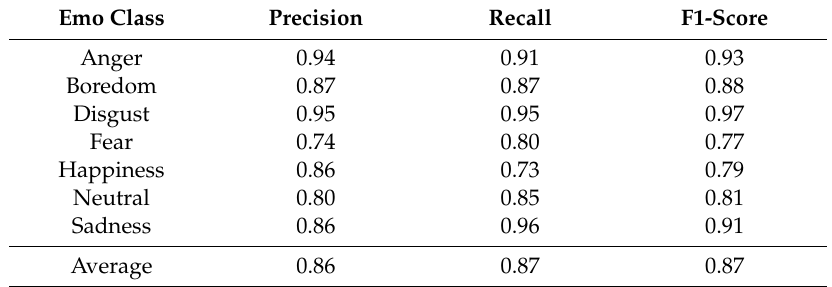
Table 5. Cross-corpus emotion recognition result using proposed fine-tuning method on EmoDB.